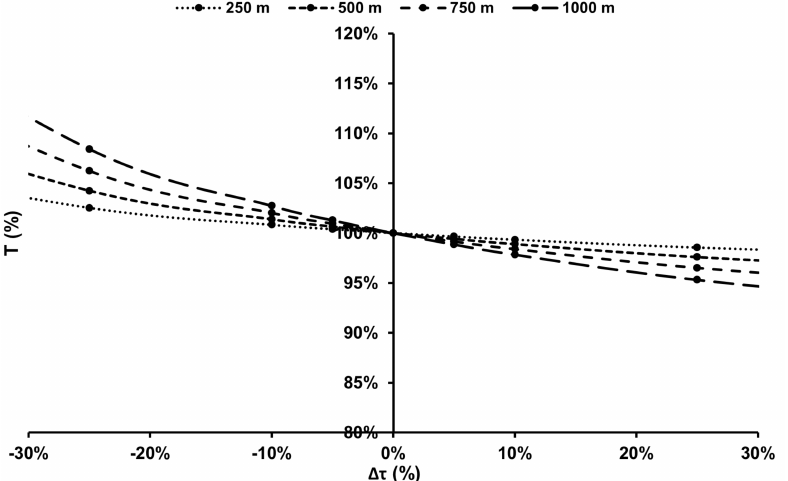
Figure 12. Change in the calculated run-time of the generic athlete as a function of change in the time constant τ for distances from 250 m to 1000